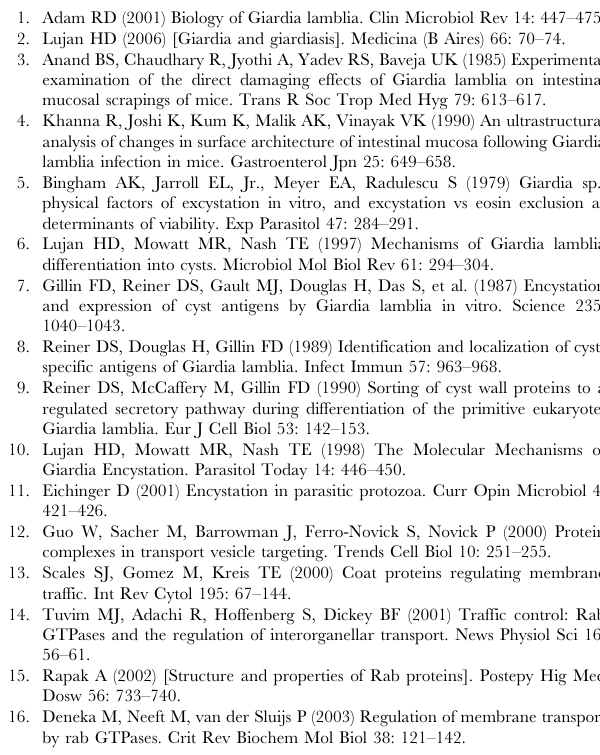
Figure S1 Alignment of Giardia Rab11 ribozymes against the rab11 sequence. (A) Alignment of pC631pac-Rab11B with rab11 antisense sequence. (B) Alignment of pC631pac-Rab11M with rab11 sense sequence. The red line indicates the ribozyme motifs. Found at: doi:10.1371/journal.pntd.0000697.s001 (1.81 MB TIF) Figure S2 Alignment of pC631pac-Rab11B ribozyme against Giardia rab11, rab1a, and rab2a antisense sequences. (A) rab11 (GenBank accession no. AF460175). (B) rab1a (GenBank accession no. XM_001704374). (C) rab2a (GenBank accession no. XM_001707245). Dotted boxes in A, B and C indicate the cutting site, and the red line in A indicates the ribozyme motifs. Found at: doi:10.1371/journal.pntd.0000697.s002 (1.65 MB